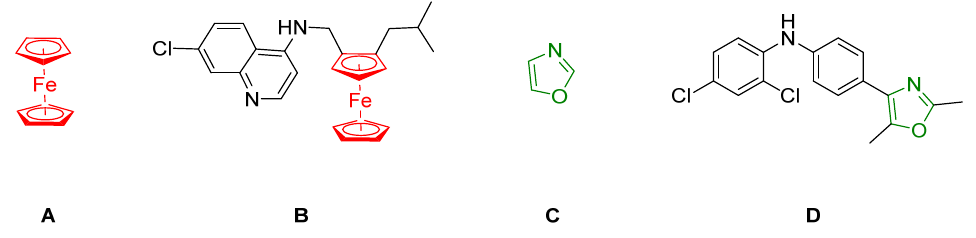
Figure 1. ( A ) Ferrocene, ( B ) Ferroquine, ( C ) 1,3 ‐ Oxazole, and ( D ) antimalarial agent.